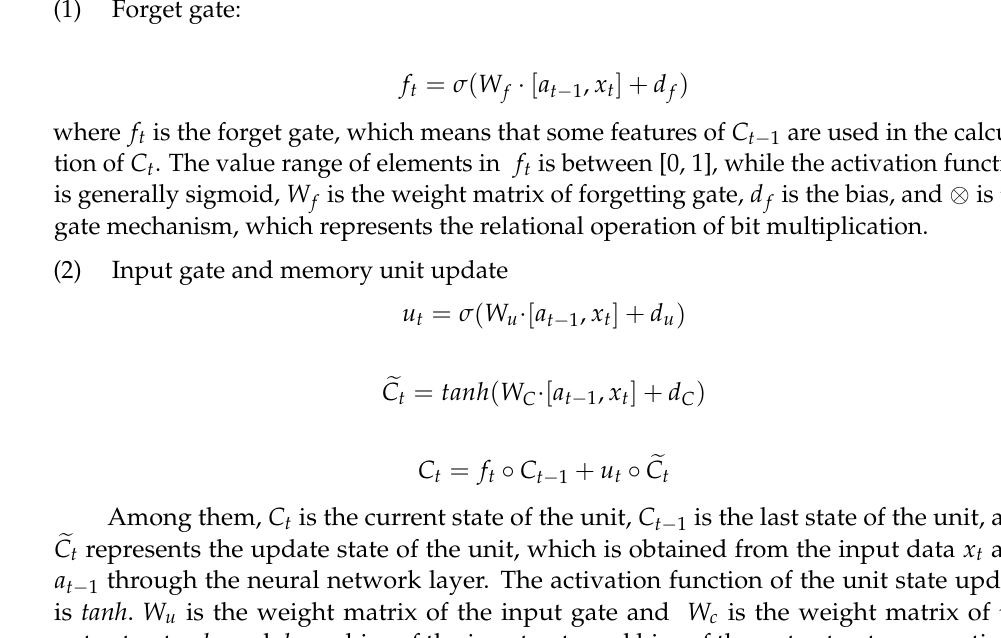
Figure 3. The cell structure of long short-term memory (LSTM).